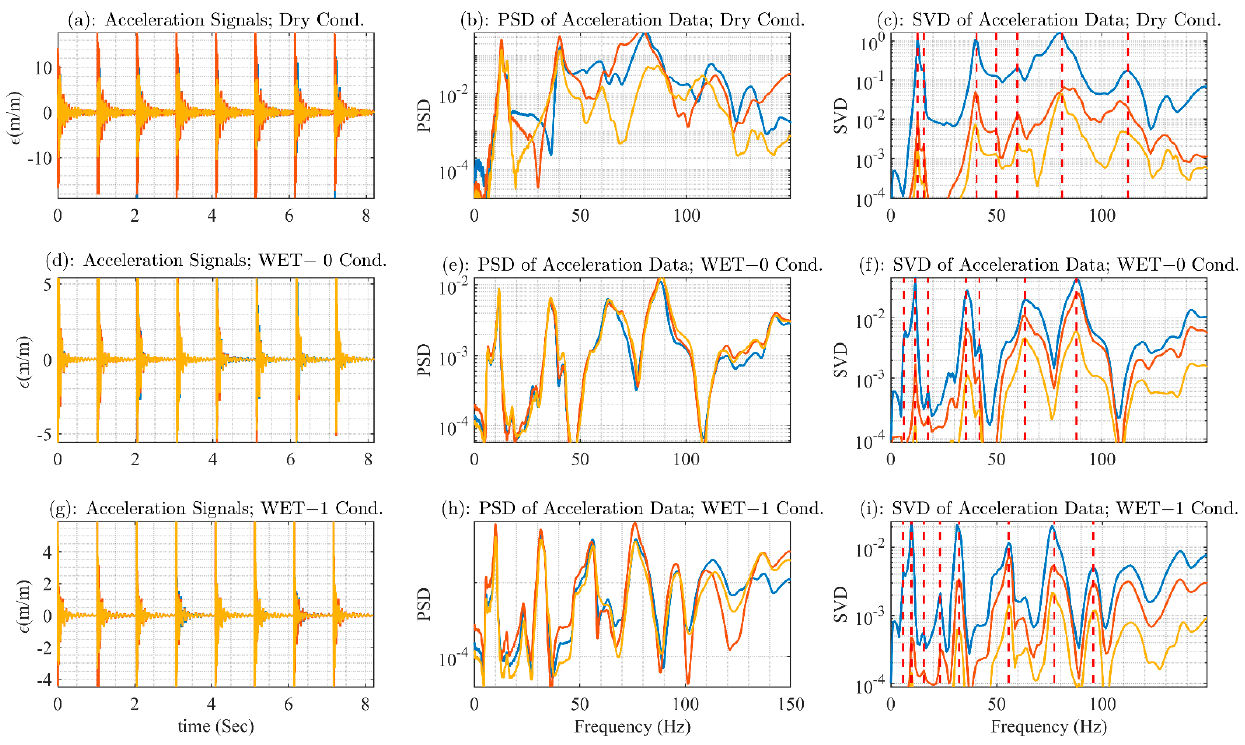
Figure 9. Acceleration data from experimental setup of the small-scale model for NFs extraction by FDD and SVD. The first column ( a , d , g ) shows the acceleration signals for the dry, semi-inundated, and fully inundated cases, respectively; the second column ( b , e , h ) shows the acceleration PSD signals for the dry, semi-inundated, and fully inundated cases, respectively; the third column ( c , f , i ) shows the acceleration SVD signals with detected system poles indicated by vertical dashed lines, passing through the peaks of the SVD signals, for the dry, semi-inundated, and fully inundated cases, respectively.